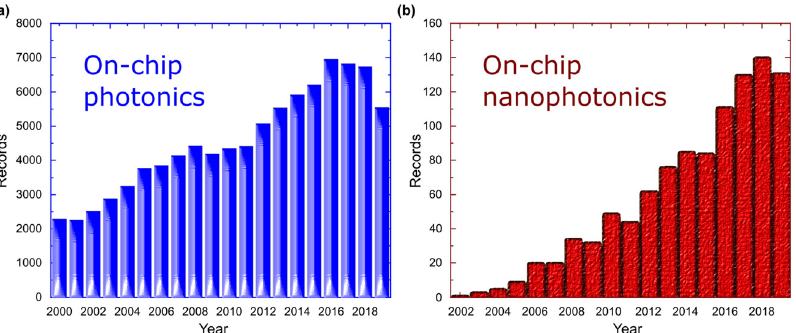
Figure 1: Evolution of on-chip nanophotonic devices over the years 2000 – 2019: (a) Bar chart of publication records in field of on- chip photonics and waveguides (from the Web of Science), (b) Bar chart of publica- tion records in field of on-chip nano- photonics (from the Web of